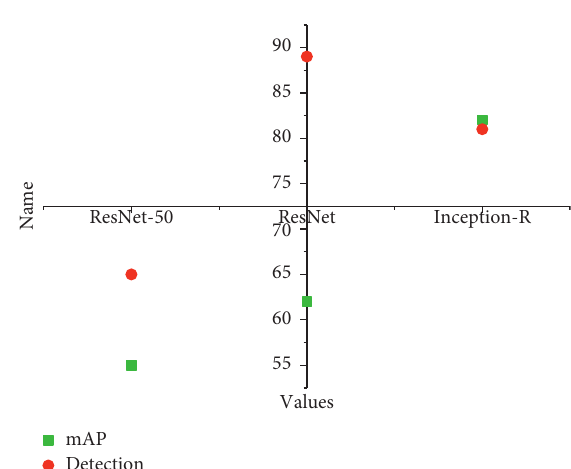
Figure 7: Test results for the three networks after combining